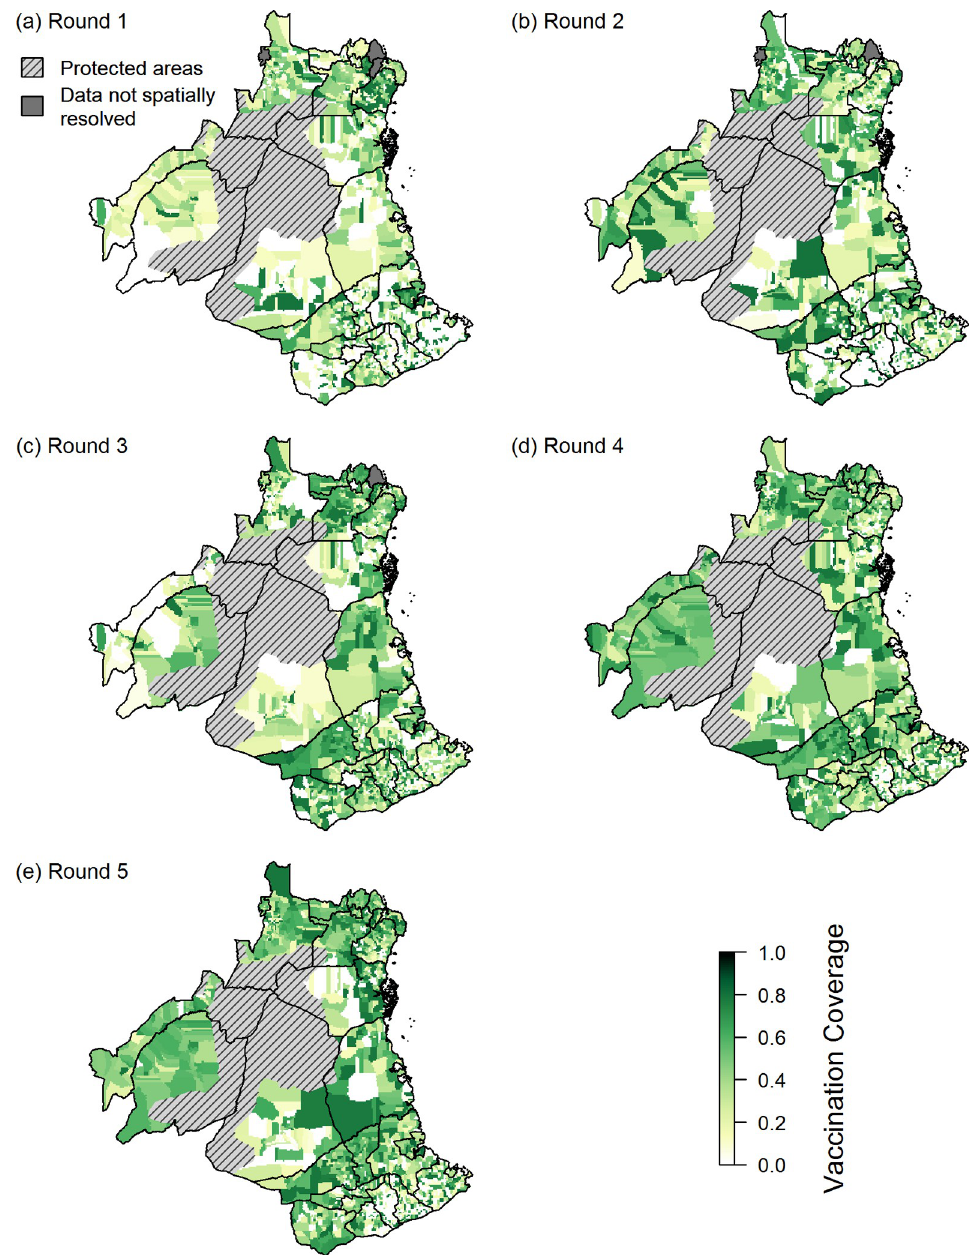
Fig 3. Coverage achieved in the five rounds of vaccination campaigns at the level of the vaccination unit. Coverage for rounds 1 and 2 was calculated using projected dog population estimates, while coverage for rounds 3–5 coverage were estimated as explained in the Methods. Darker green shading corresponds to higher coverage while white shading indicates that no vaccination campaign was undertaken. Hatched represents forest reserves or wildlife-protected areas. Shapefiles to make this figure were downloaded from the Diva GIS data portal (https://www.diva-gis.org/).